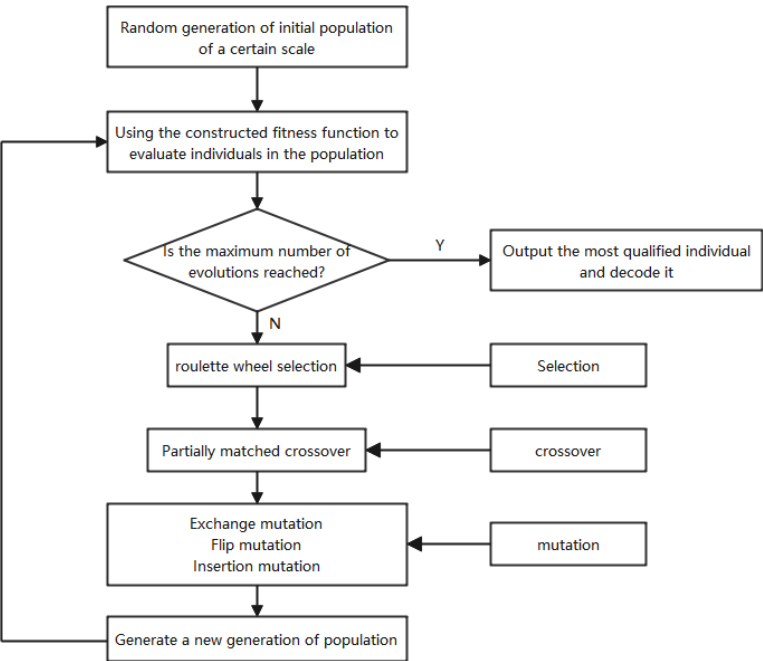
Figure 1. Operation process of the genetic algorithm.